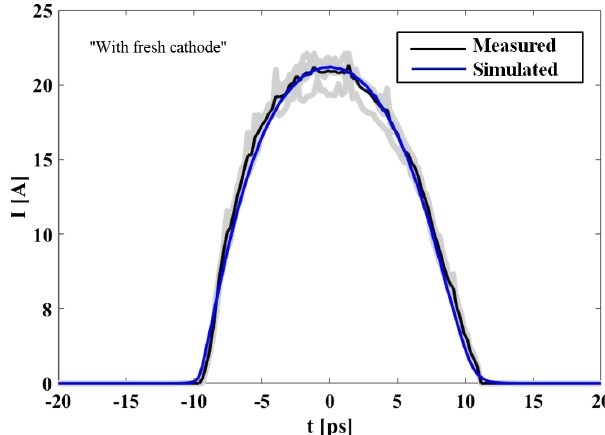
FIG. 18. Comparison of the bunch profile between measure- ment and simulation at 250 pC. The shading curves show 5 individual measurements and the solid black curve shows the average. The blue curve stands for the simulation